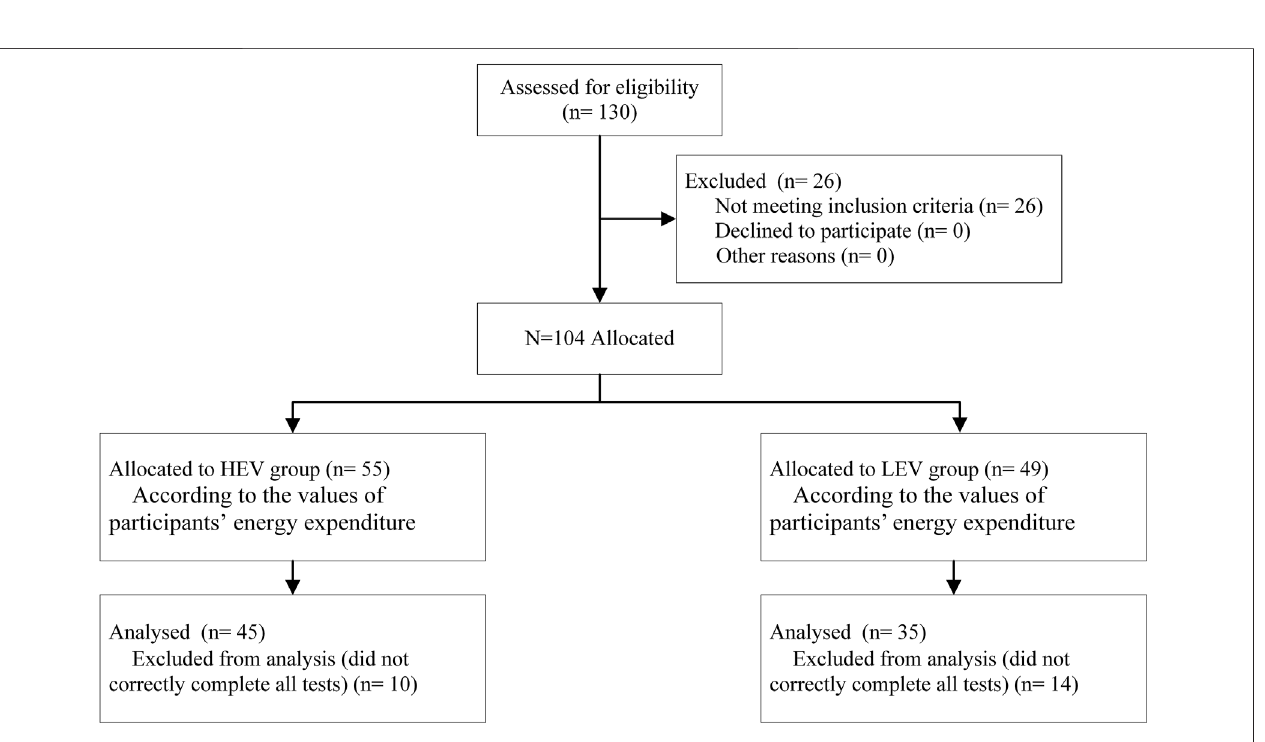
FIGURE 2 | Enrollment diagram of all